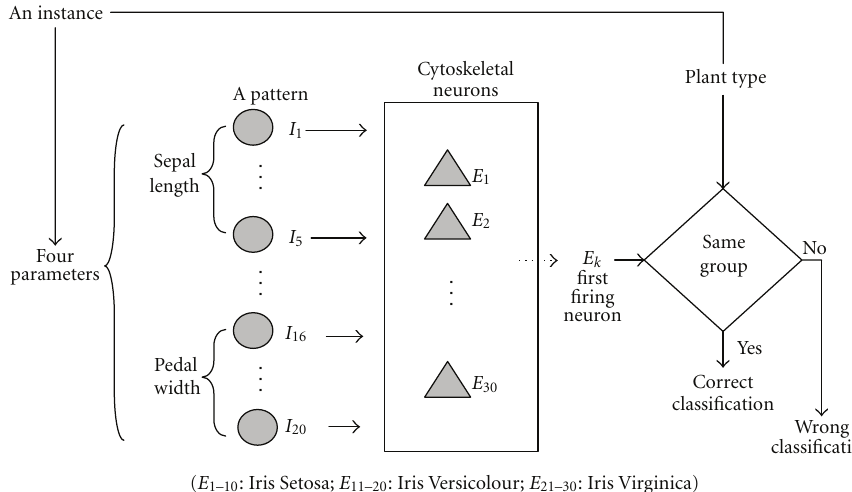
Figure 8: Interface of the ANM design with the IRIS